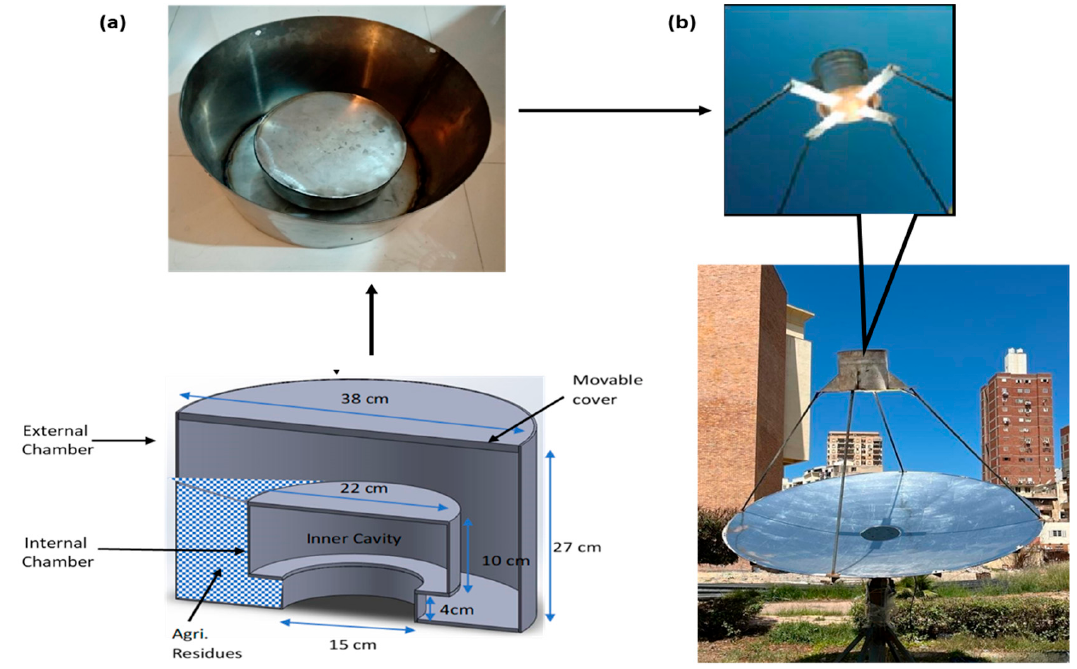
Figure 1. Pyrolysis Chamber Reactor Design Diagram: ( a ) Schematic layout; and ( b ) Parabolic Dish Collector Fabrication Design.